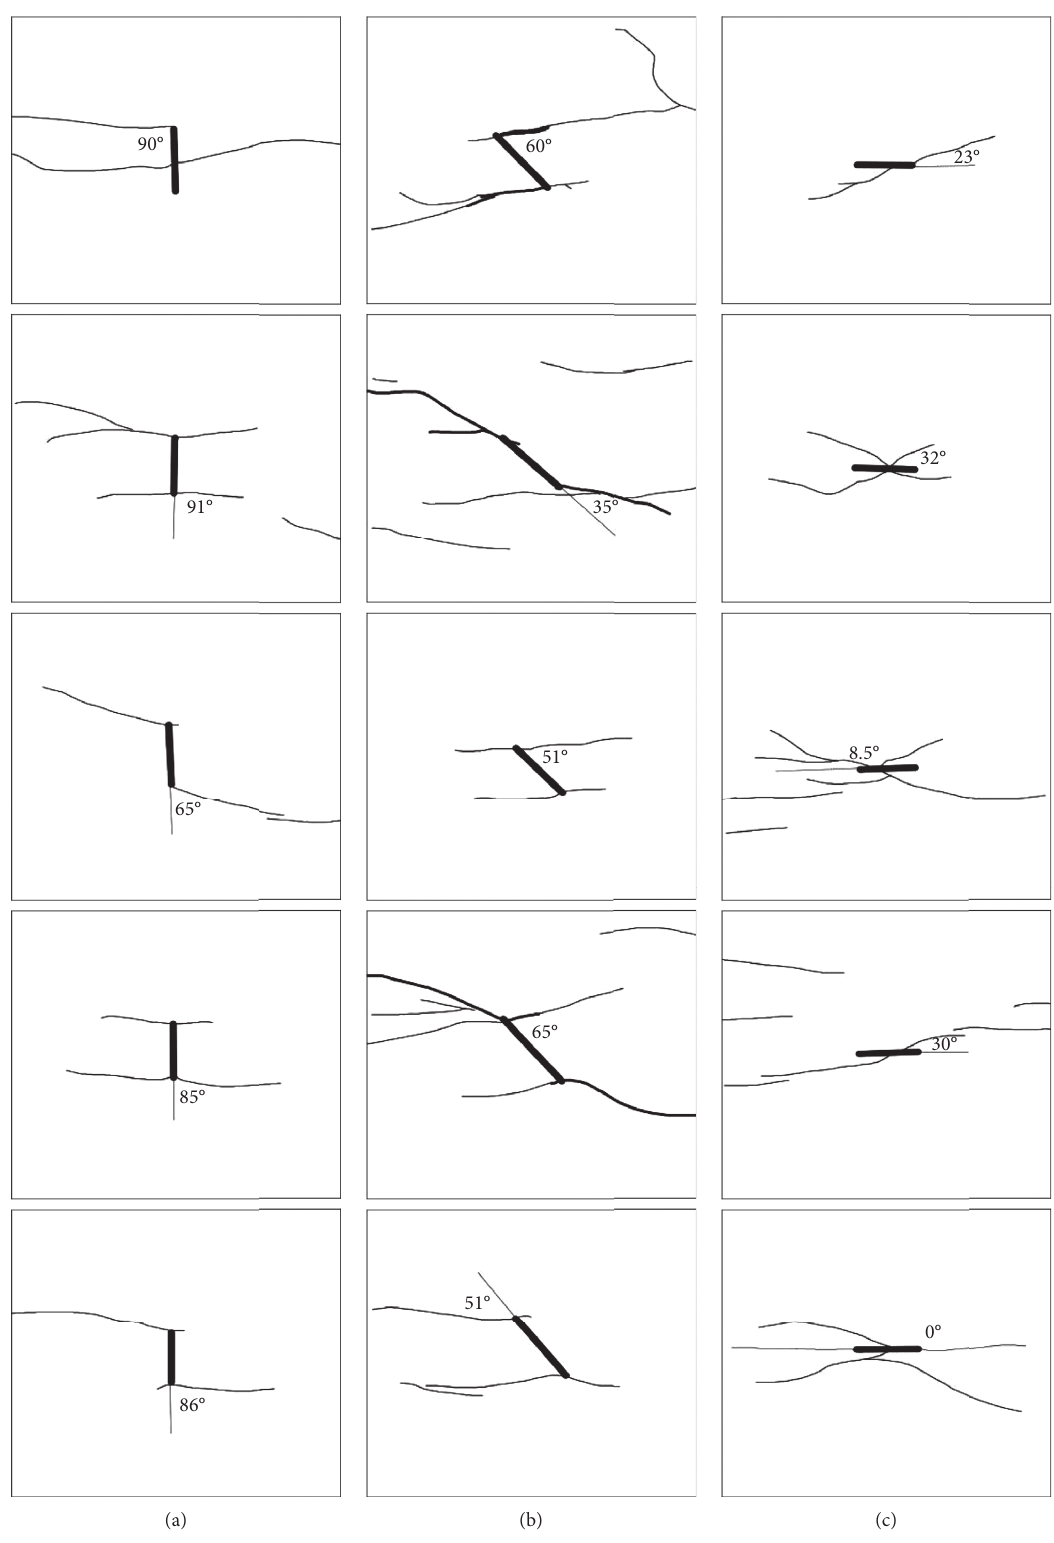
Figure 11: Crack initiation angle diagram. (a) 0 ° . (b) 45 ° . (c) 90 °